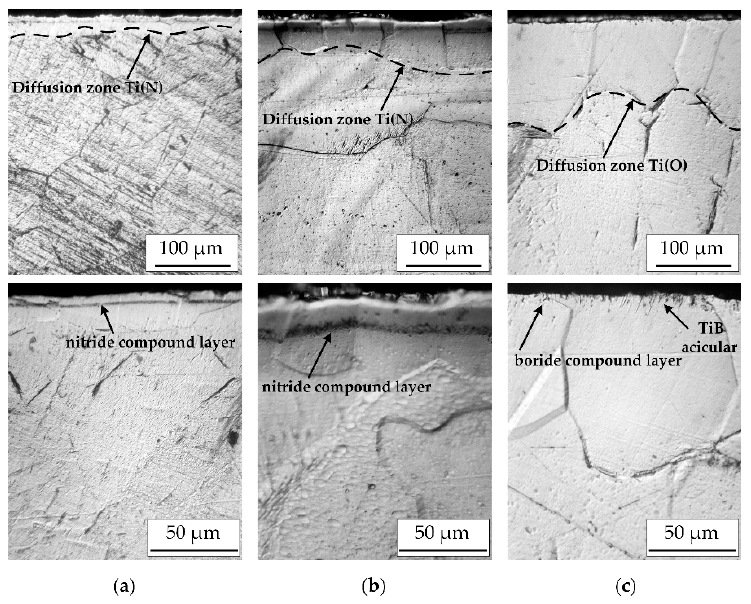
Figure 8. Microstructure of the near-surface layer of titanium Grade 2 after nitriding at 750 ◦ C ( a ) and 900 ◦ C ( b ) and after boriding ( c ).